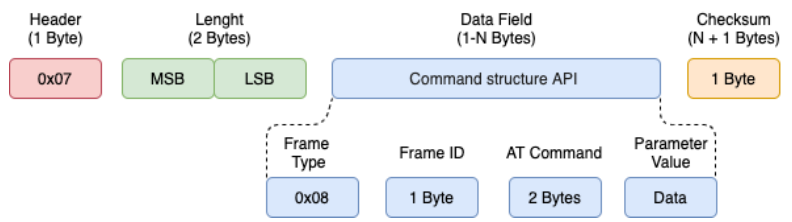
Figure 7. Generic protocol with AT command.